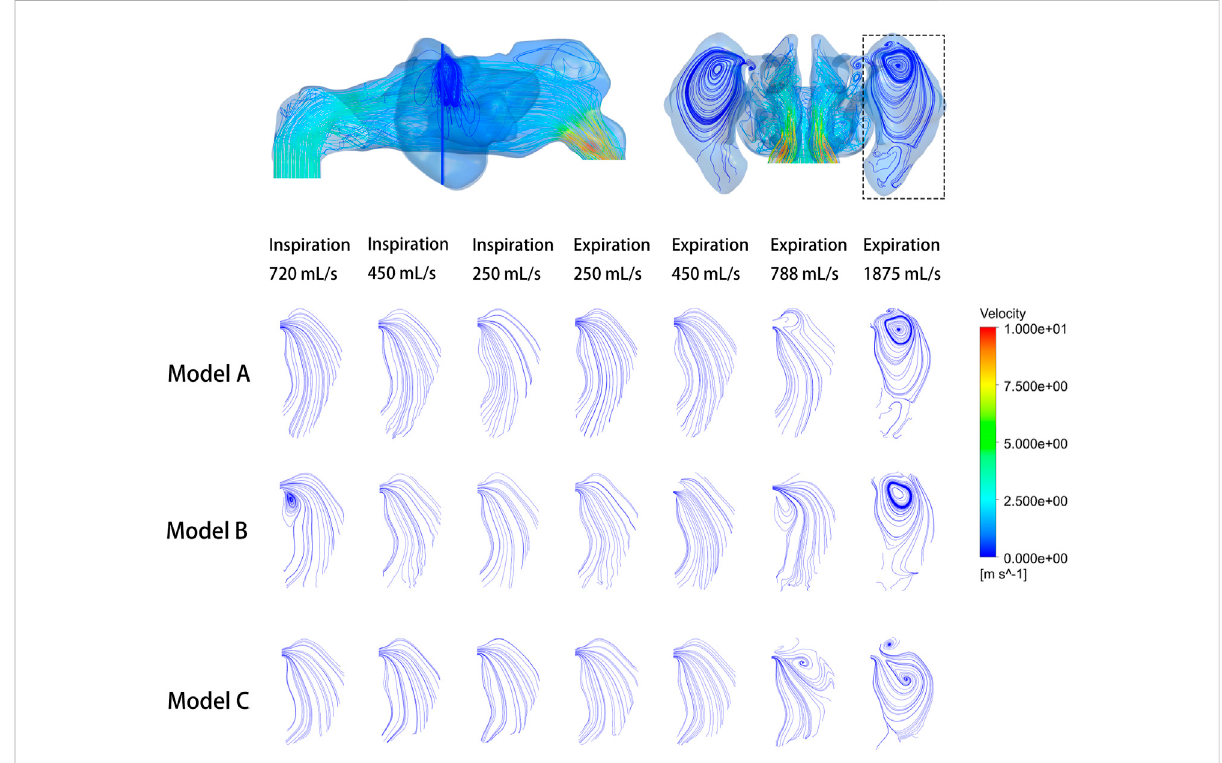
FIGURE 4 Velocity streamline at the cross-section plane of the pre- and post-operative sinuses under different inlet fl ow rates.